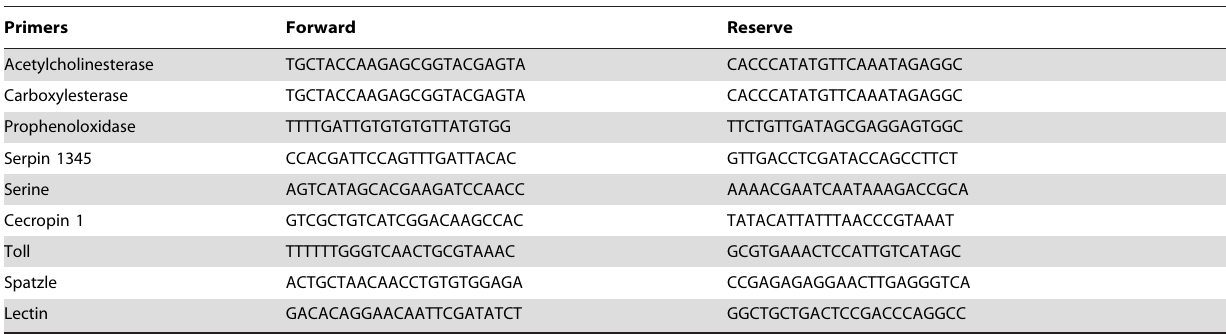
Table 2. The primers used in